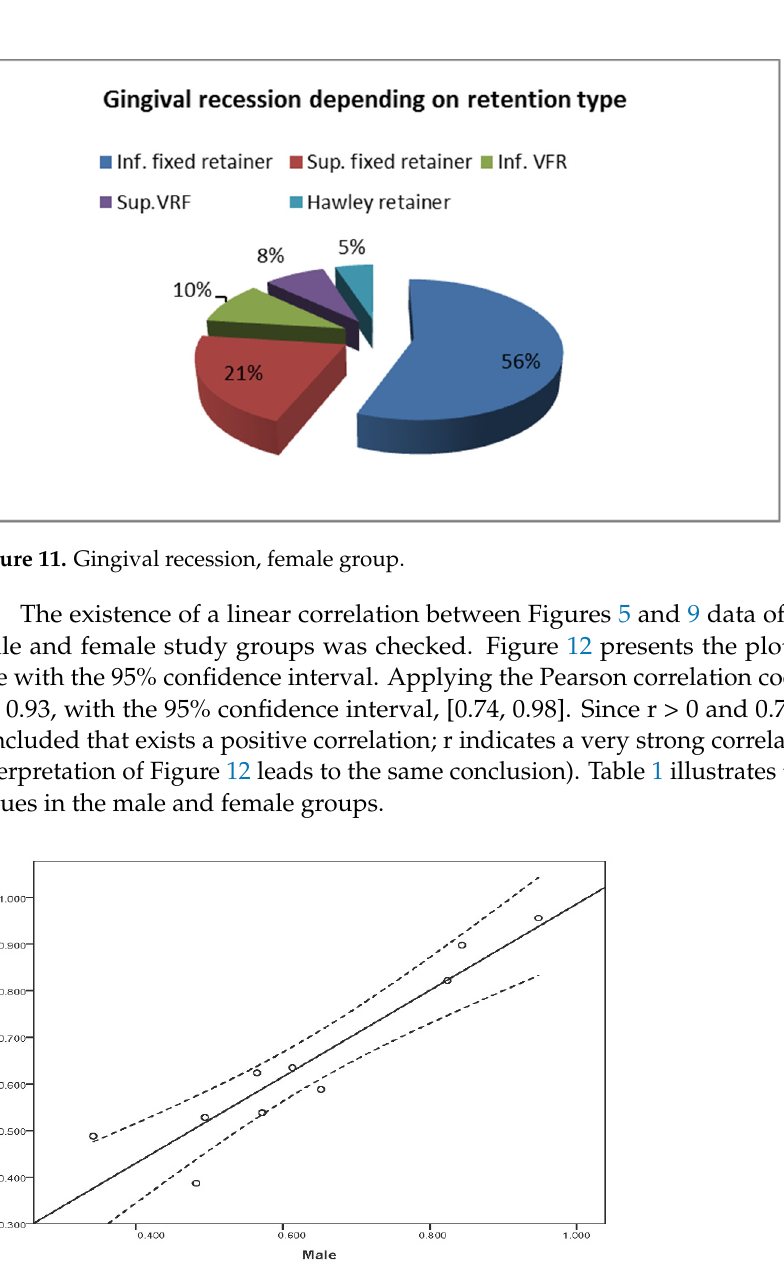
Figure 10. Turesky Modified Quigley-Hein Plaque Index, female study group.